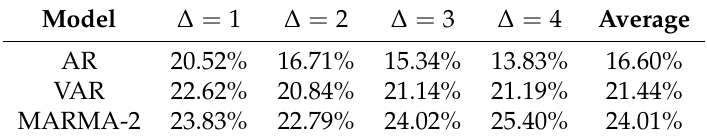
Table 4. The percentage improvements in MAE of the models with respect to persistence